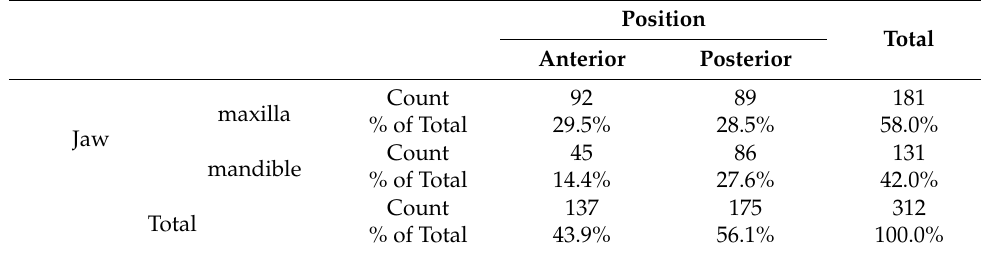
Table 2. Frequency of implant distribution by site of placement.